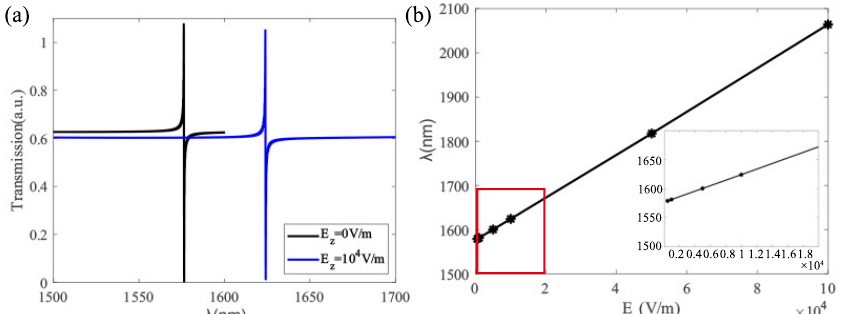
Figure 9. ( a ) Normalized transmission spectrum with applied electric field of E z = 10 4 V/m and without applied electric field in parameter a = 480 nm, r = 175 nm, s = 5 nm, t = 200 nm. ( b ) Variation of resonance wavelength λ res with applied electric field in same parameters, the inset corresponds to the variation in the red rectangle.